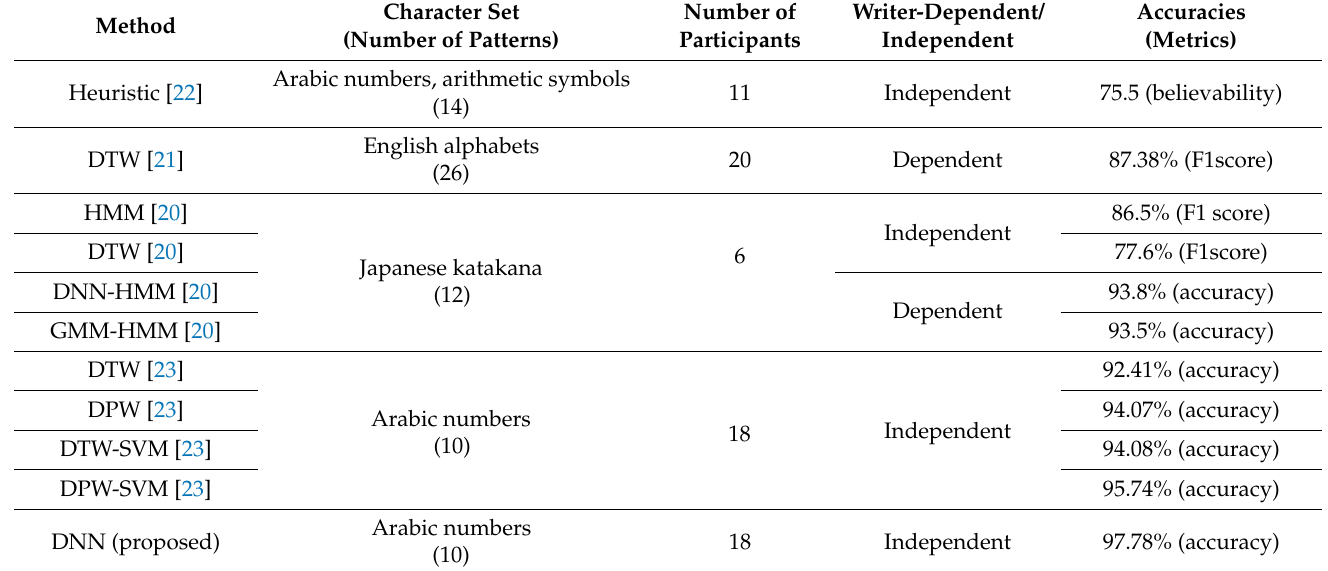
Table 1. Recognition accuracies of eye-written characters with different methods.